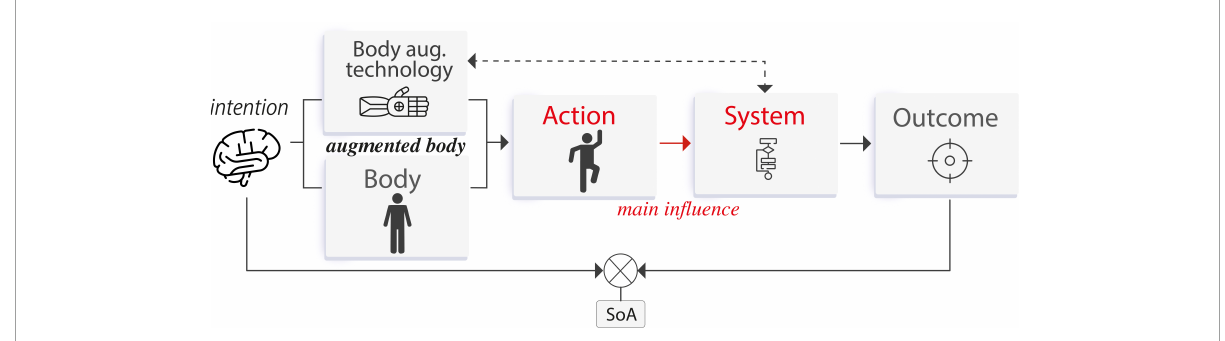
FIGURE4 Agency process for body augmentation technology. The user’s action controls the system to produce an intended outcome. Crucially, the outcome is a body